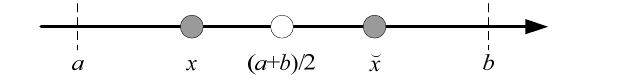
Figure 1. Opposite point defined in domain [ a , b ]. x is a candidate solution and x  is the opposite of x .